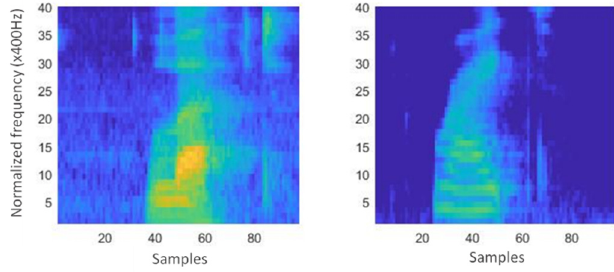
Figure 2. Spectrogram samples of foul language (40-by-97).